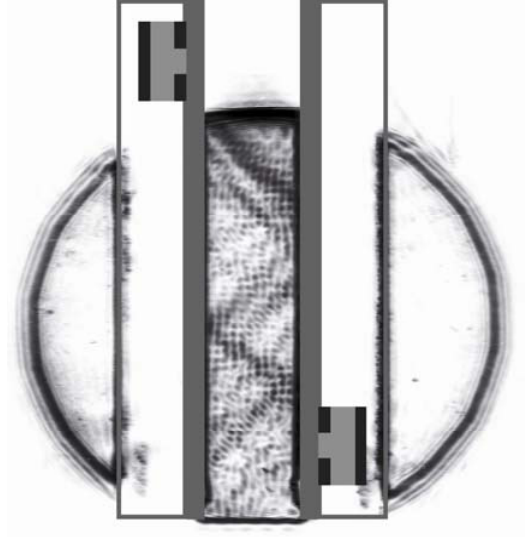
Figure 7. Schlieren image of sound propagation within the acoustic waveguide by continuous sinusoidal excitation of the transmitter. A zigzag propagation way can be observed. The location of the transducers and the plates are marked by a